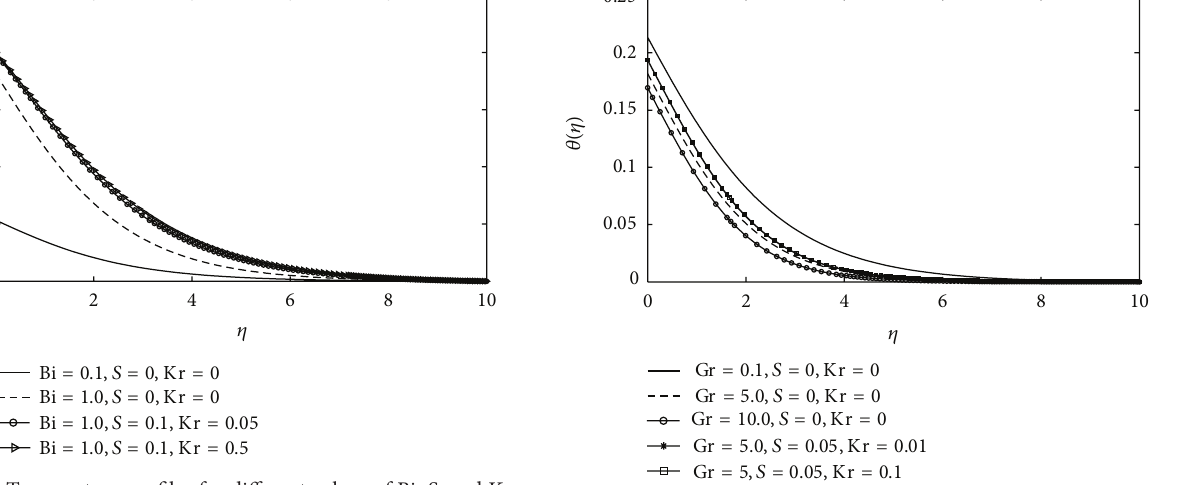
Figure 11: Temperature profiles for different values of Gr, 𝑆 , and Kr for Ha = 0.1 , Gc = 0.1 , 𝑆 c = 0.62 , Bi = 0.1 , Nc = 0.01 , and Pr = 0.72 .